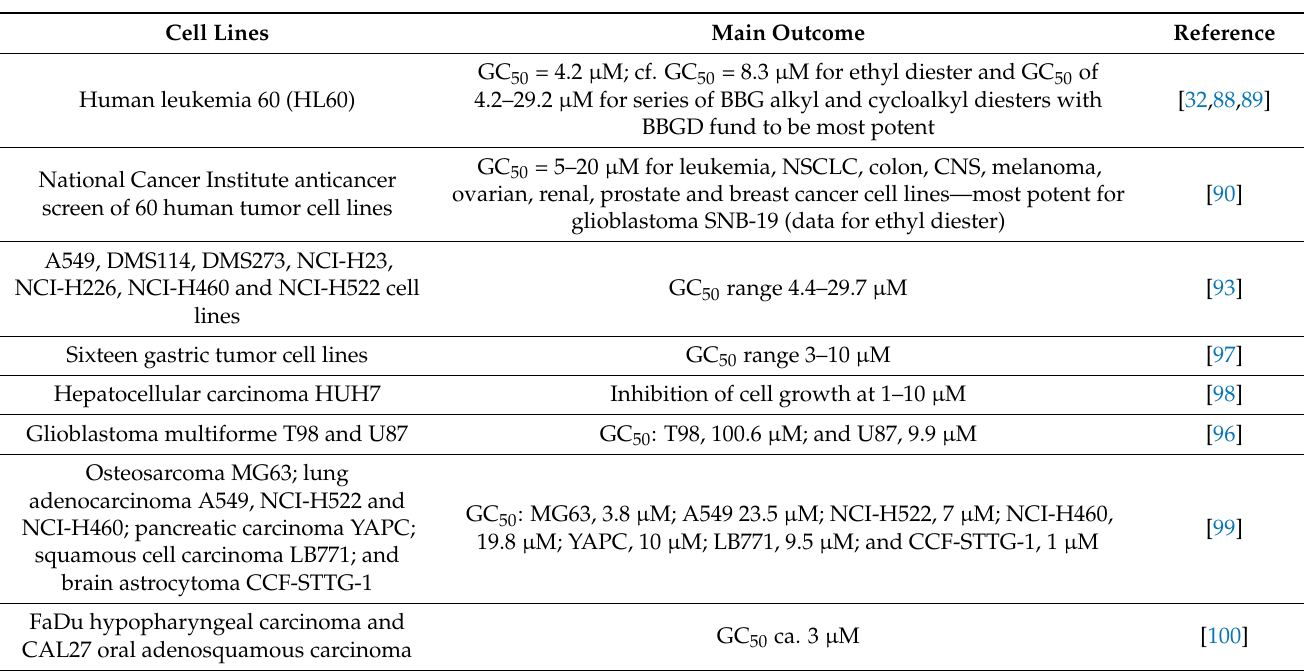
Table 2. Anti-cancer activity of cell-permeable Glo1 inhibitor, S-p-bromobenzylglutathione cy- clopentyl diester, with human tumor cells lines in vitro.